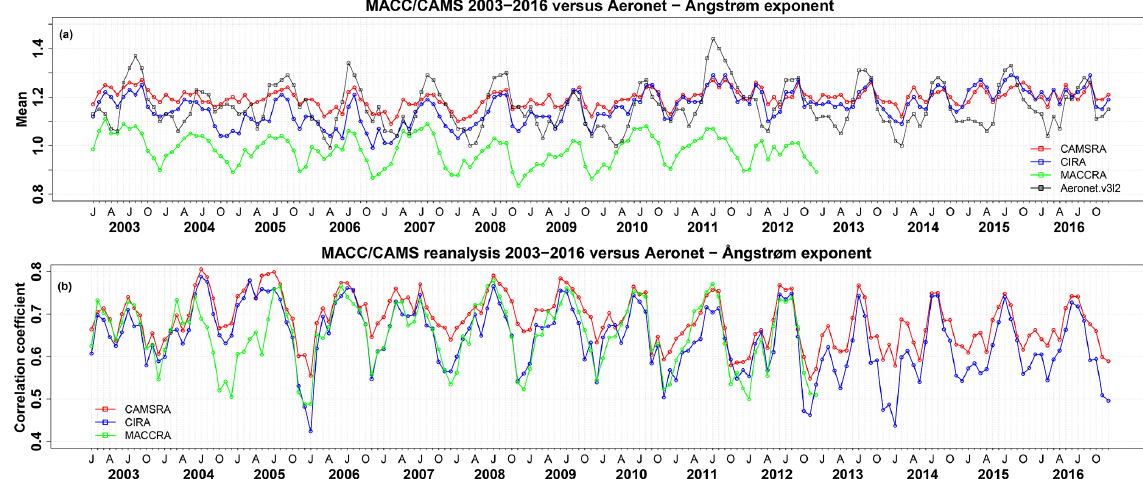
Figure 24. Evolution of (a) global mean Ångström exponent at AERONET sites based on matching daily data from model and AERONET, and (b) correlation using daily matching Ångström exponent from model and AERONET. CAMSRA is shown in red, CIRA in blue, MACCRA in green and AERONET Version 3 Level 2.0 observations in